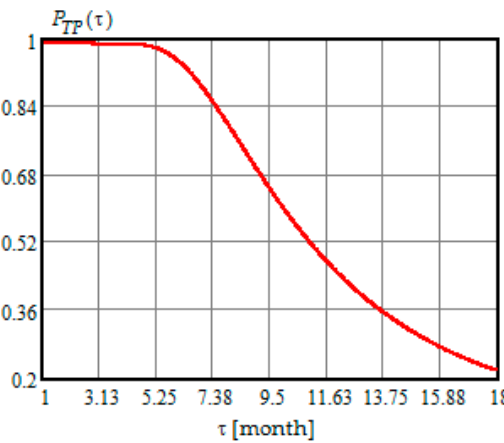
Figure 6. The dependence of the probability of false positive on the length of the interval τ . Energies 2019 , 12 , x FOR PEER REVIEW